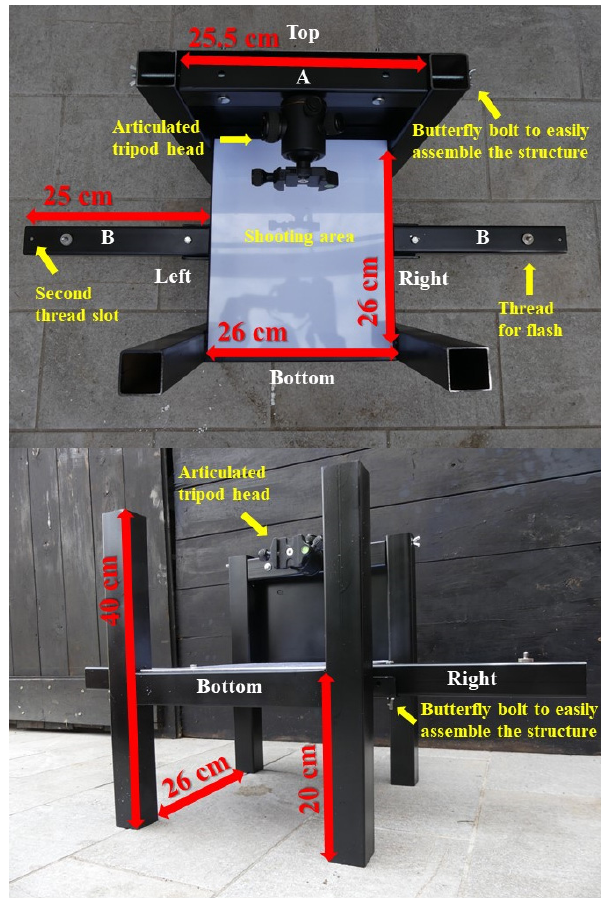
Figure 1. View from above (up) and from a lower angle (down) of the portable photographic studio. Within picture are indicated: the oriented sides (Top, Right, Bottom and Left), the threads for flashes and their second slots on removable segments B, the shooting area, the articulated tripod head attached to the removable segment A. Red arrows indicate the segments; beside each arrow the relative measure is also reported. All iron segments are 4 × 4 cm.